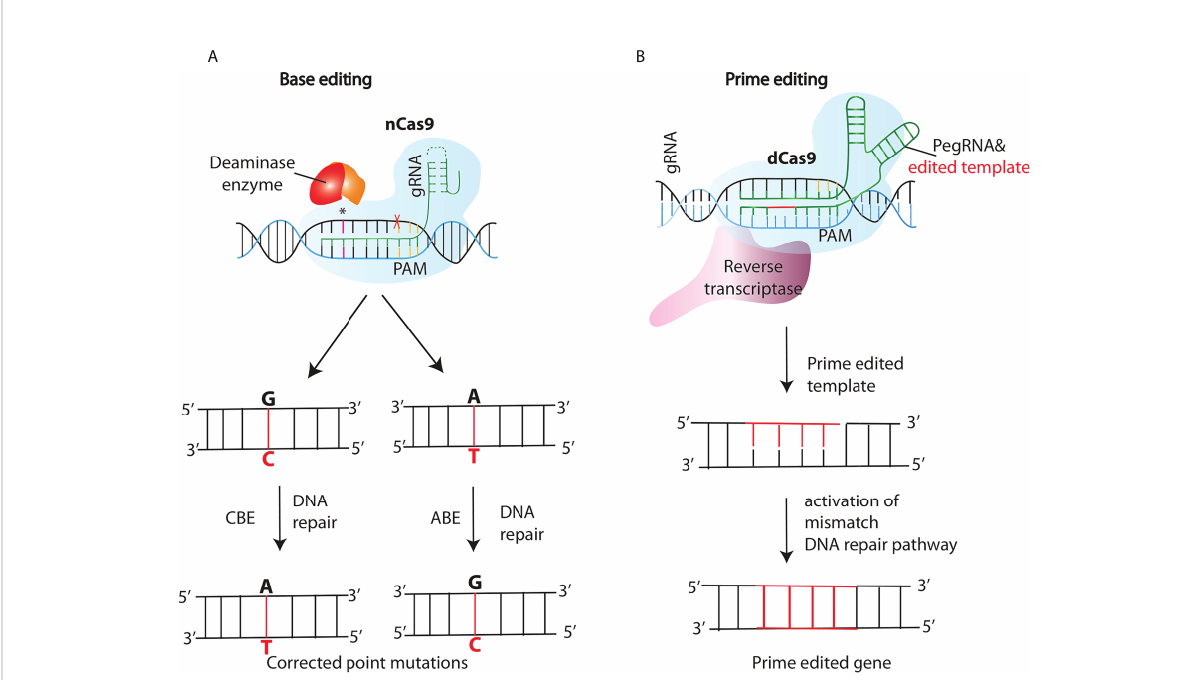
FIGURE 4 New generations of genome editing tools- base and prime editing. (A) Cytosine and adenine base editors (CBEs or ABEs), consist of a nickase Cas9 (nCas9) fused to a deaminase that nicks the opposite strand inducing a DNA repair pathway response, resulting in the conversion of C:G into T:A or A:T into G:C base pairs in the editing site. (B) In the prime editing (PE) method, a PE gRNA (pegRNA) complexes to the fused retroviral reverse transcriptase (RT)- nCas9 complex, tethering it to the target site. After the nicking of the target strand by nCas9, the RT synthesizes a new DNA strand using the sequence included in the pegRNA as a template, and thus introducing the desired